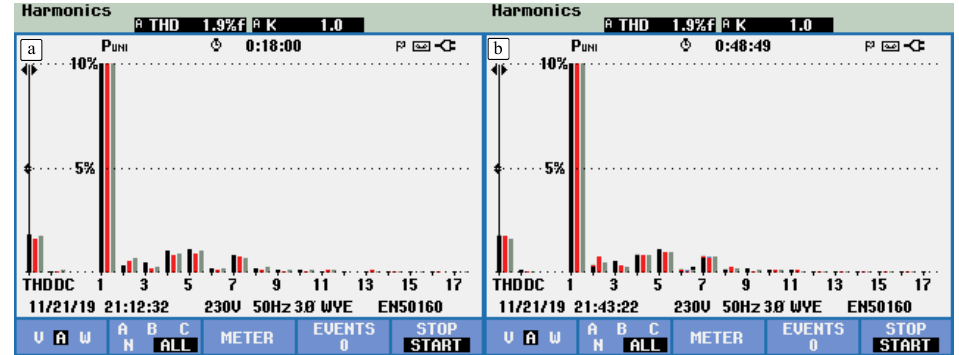
Figure 6. NPC ac currents harmonic spectrum for a 5.3 kW load. ( a ) PI controller. ( b ) HGO-Adaptive STA proposed controller.